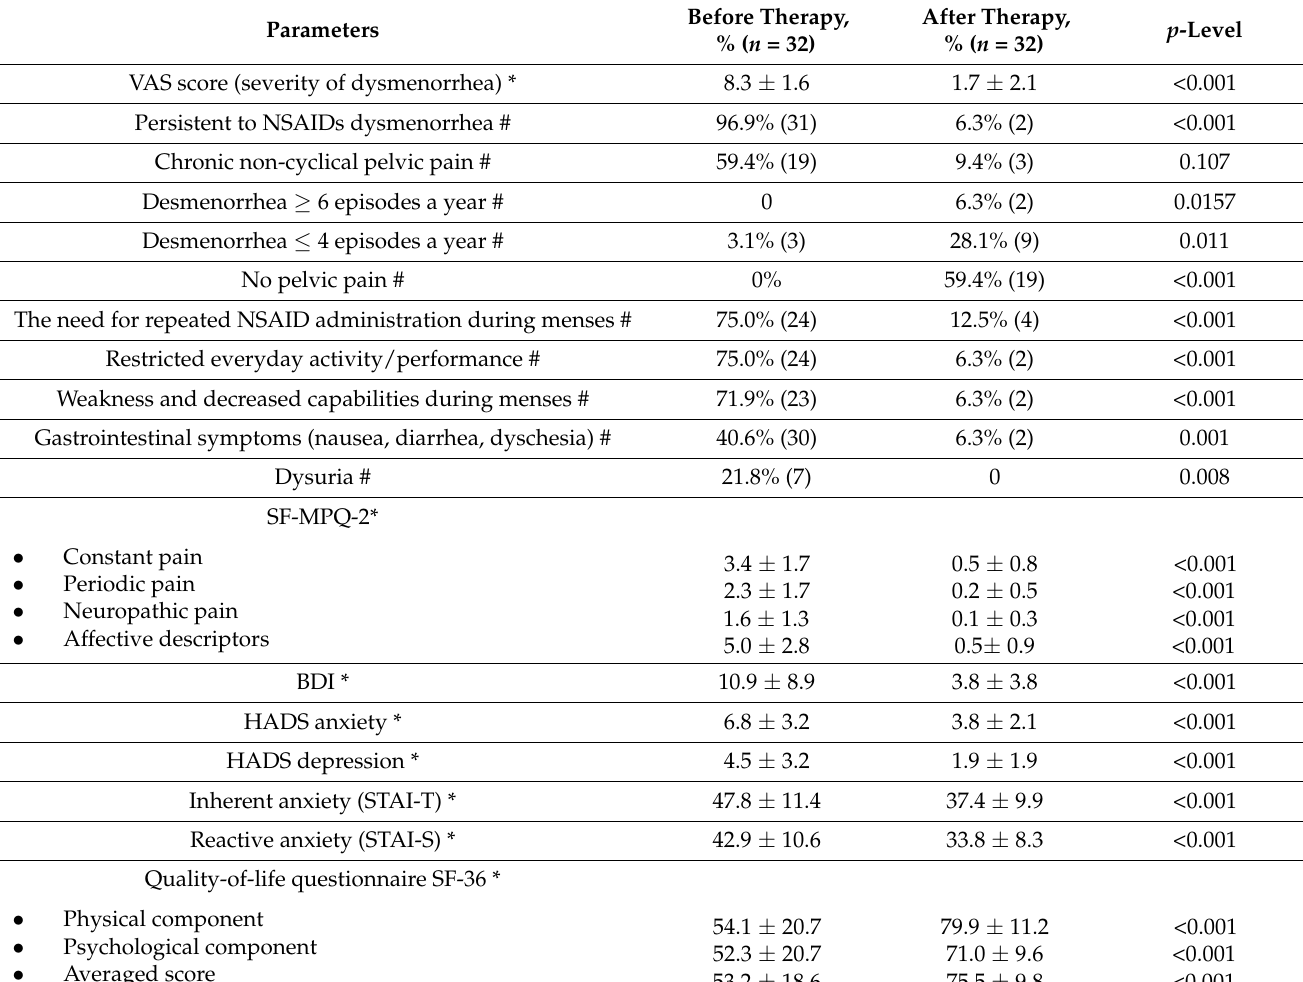
Table 1. Pain, anxiety, depression, and quality-of-life indicators before and after one-year dienogest-therapy. Parameters